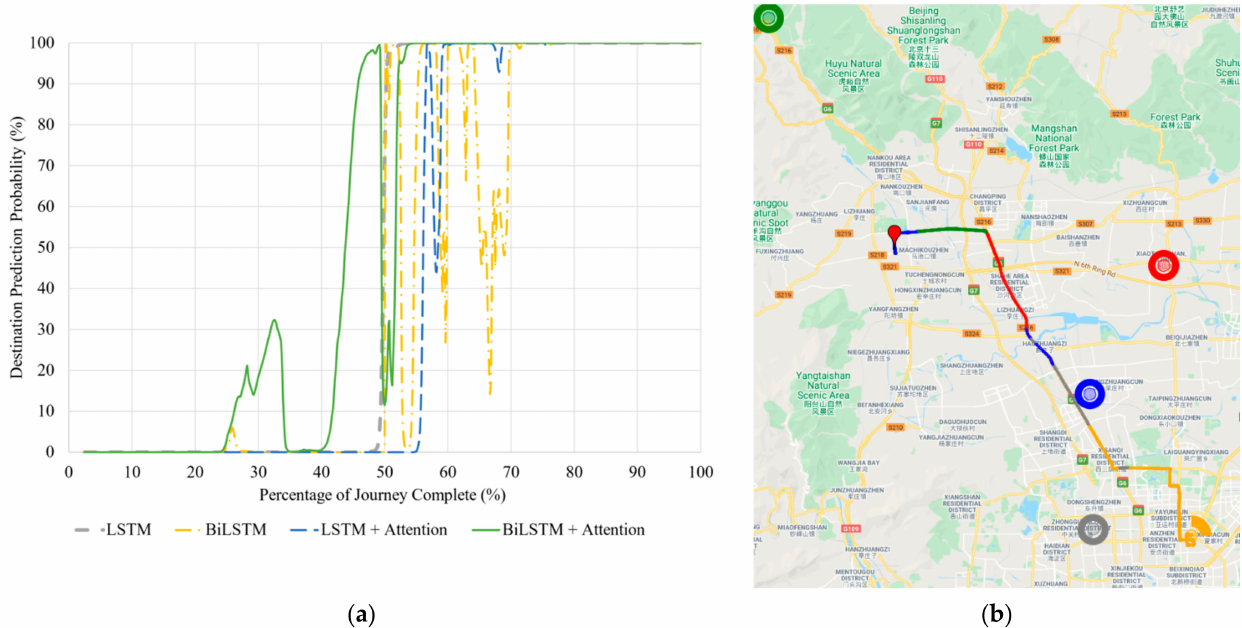
Figure 5. ( a ) Correct destination prediction versus percentage complete for the unseen journey to Destination 22. ( b ) BiLSTM with Attention destination predictions visualized along the same route. The red pin is the starting point. Map data ©